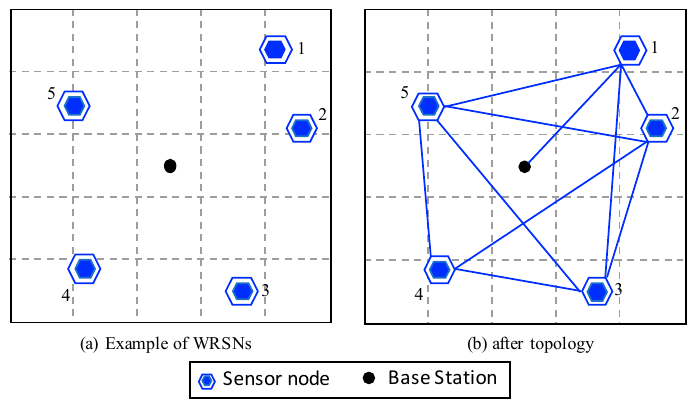
Figure 8. The topology of the example.